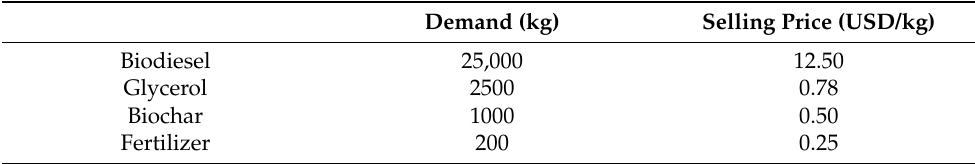
Table A1. Demand and selling price for each product [16].